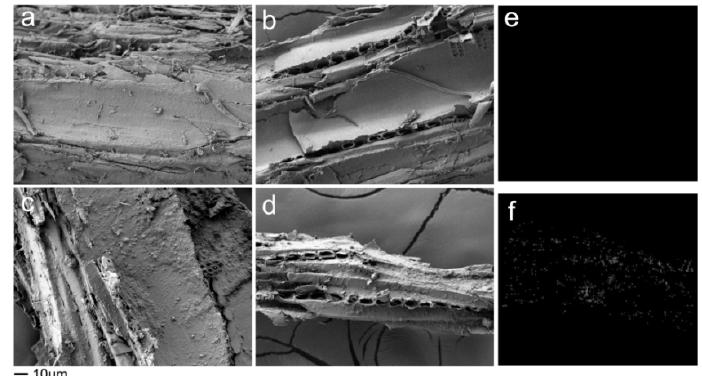
Figure 2. SEM and EDXA images of untreated and emulsion treated WFs. ( a ) without treatment; ( b ) paraffin emulsion treatment; ( c ) and ( d ) Pickering emulsion treatment; ( e ) Si distribution of ( b ); ( f ) Si distribution of ( d ).